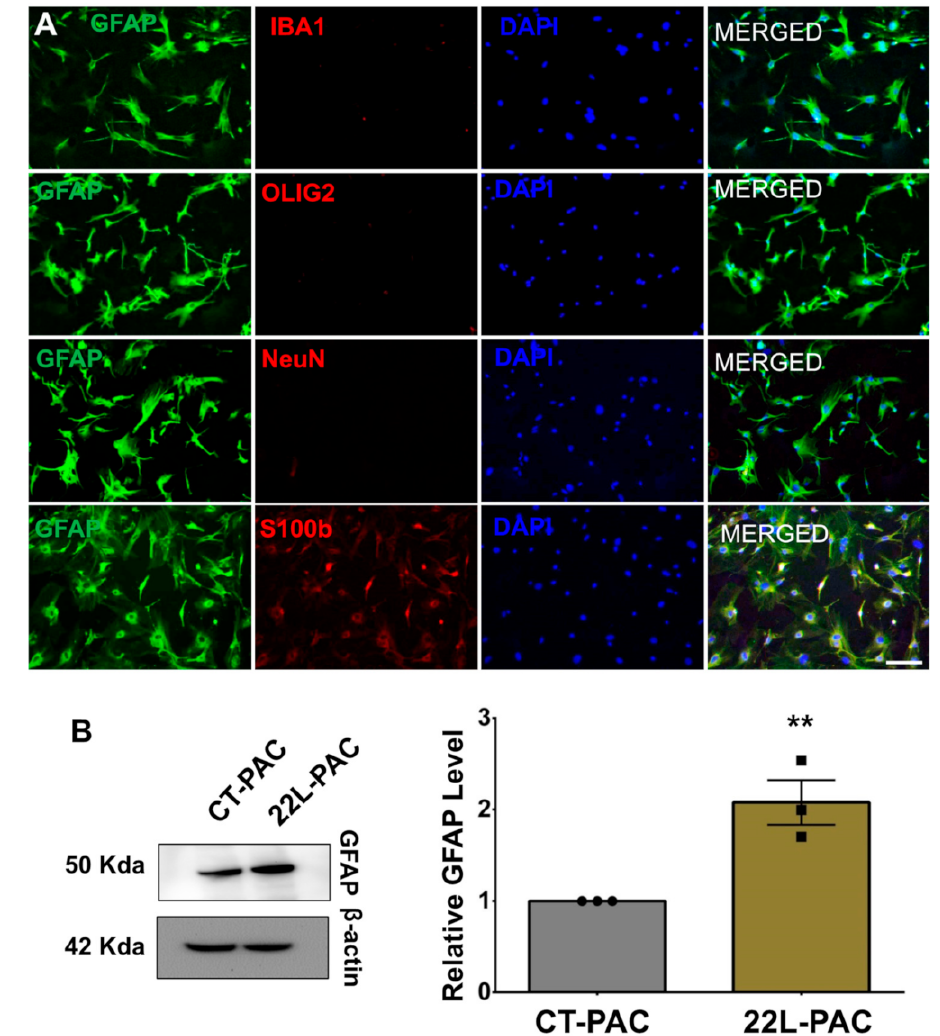
Figure 2. Preparation of adult primary astrocyte cell cultures. ( A ) Co-immunostaining of PACs using an astrocyte-specific marker (GFAP, green) and microglia- (Iba1, red), oligodendrocyte- (olig2, red), neuron- (NeuN, red) or second astrocyte- (S100 β , red) specific marker. Cell nuclei are stained with DAPI (blue). Images are representatives of three independent primary cell cultures, each prepared from an individual control animal. Scale bar = 50 µ m. ( B ) Representative Western blots (left) and densitometric analysis of GFAP expression levels (right) in CT-PACs and 22L-PACs normalized per expression of β -actin. Data are expressed as mean ± SEM, n = 3 independent cultures isolated from individual animals, ** p < 0.01 (two-tailed, unpaired student